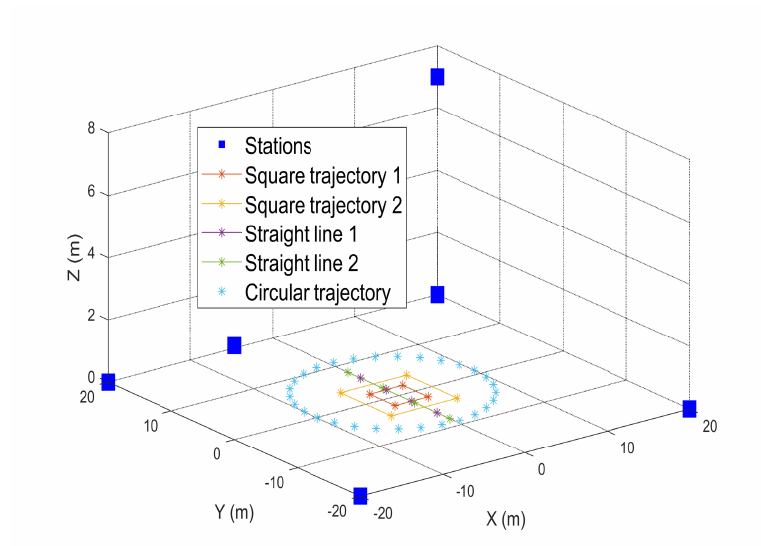
Figure 4. The high-precision positioning process of GDD model The coordinates of the transmitting antenna are shown in Table 1. Table 1. Coordinates of transmitter